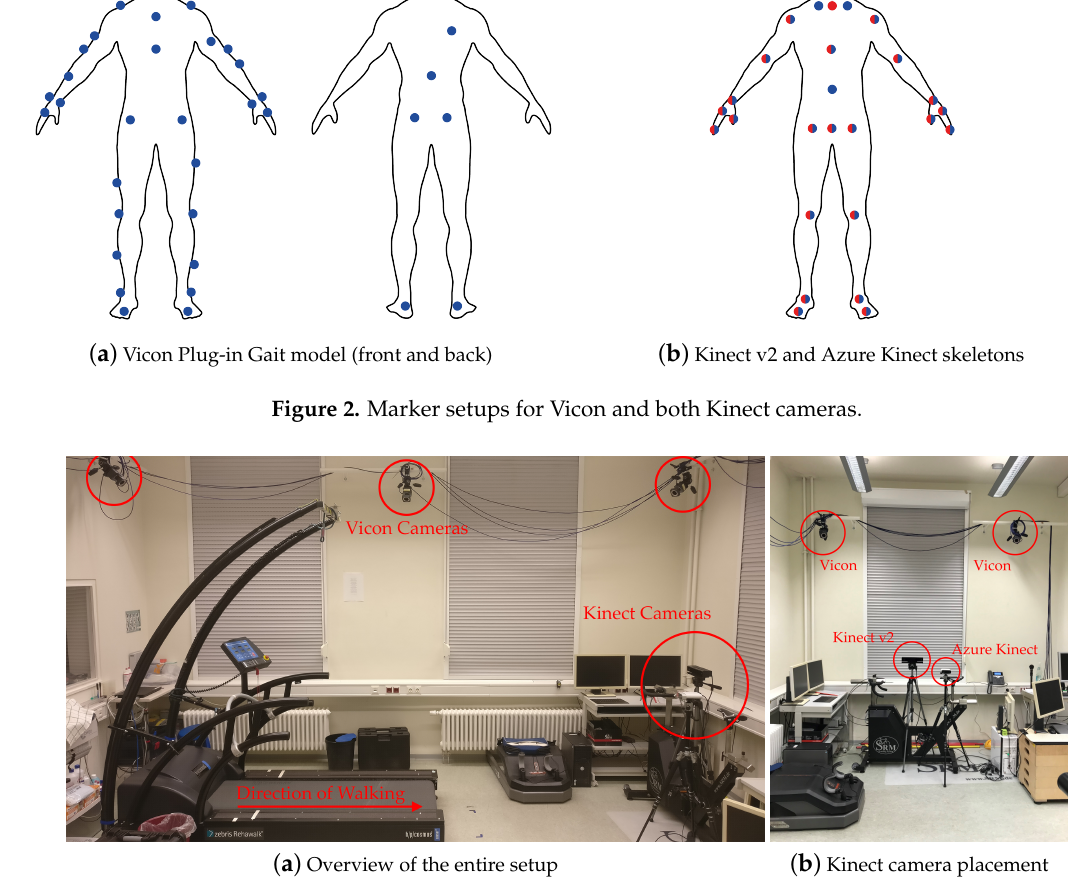
Figure 3. Experimental setup in the laboratory. Both Kinect cameras were placed in front of the treadmill. The joints tracked by both Kinect cameras are approximate and anatomically